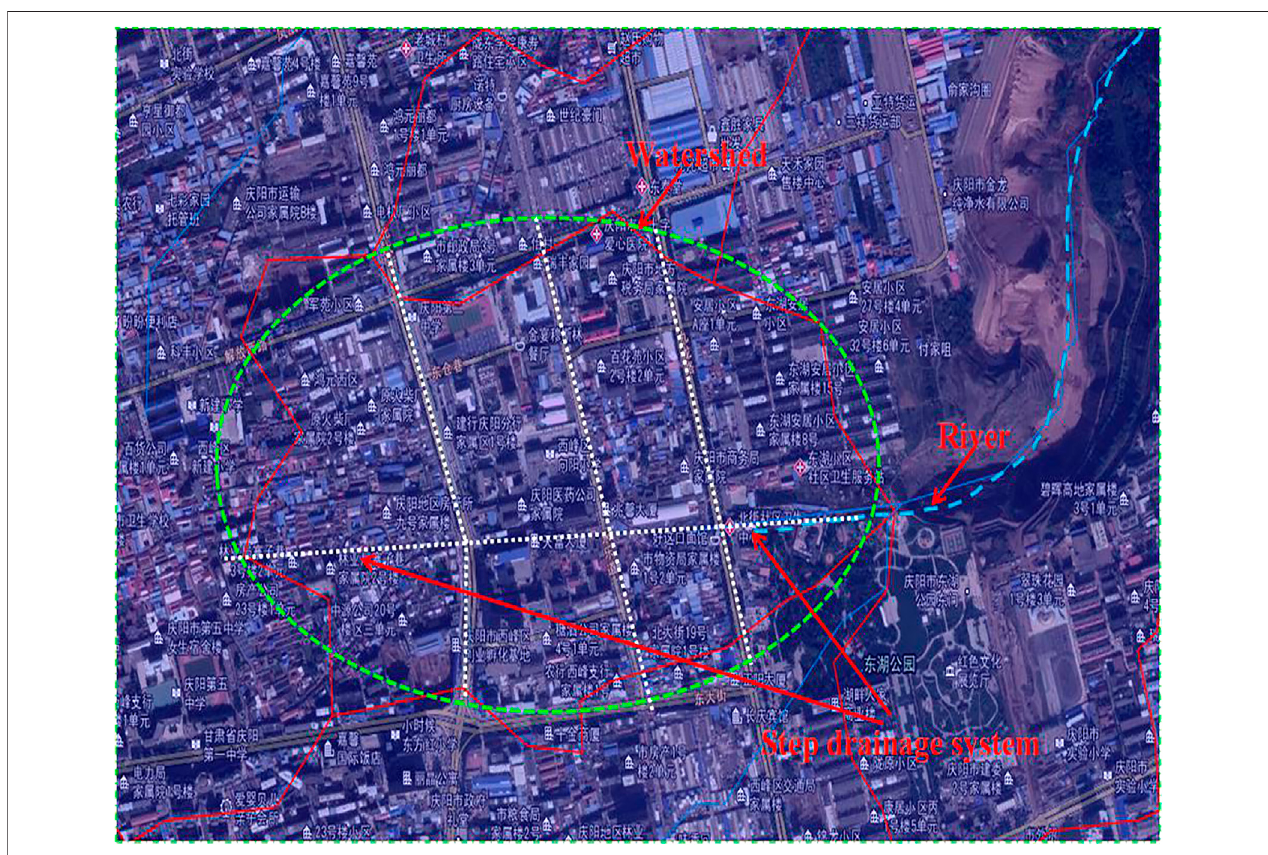
FIGURE 7 | Cascade drainage system established along the road (taking Huoxiang gully as an example).